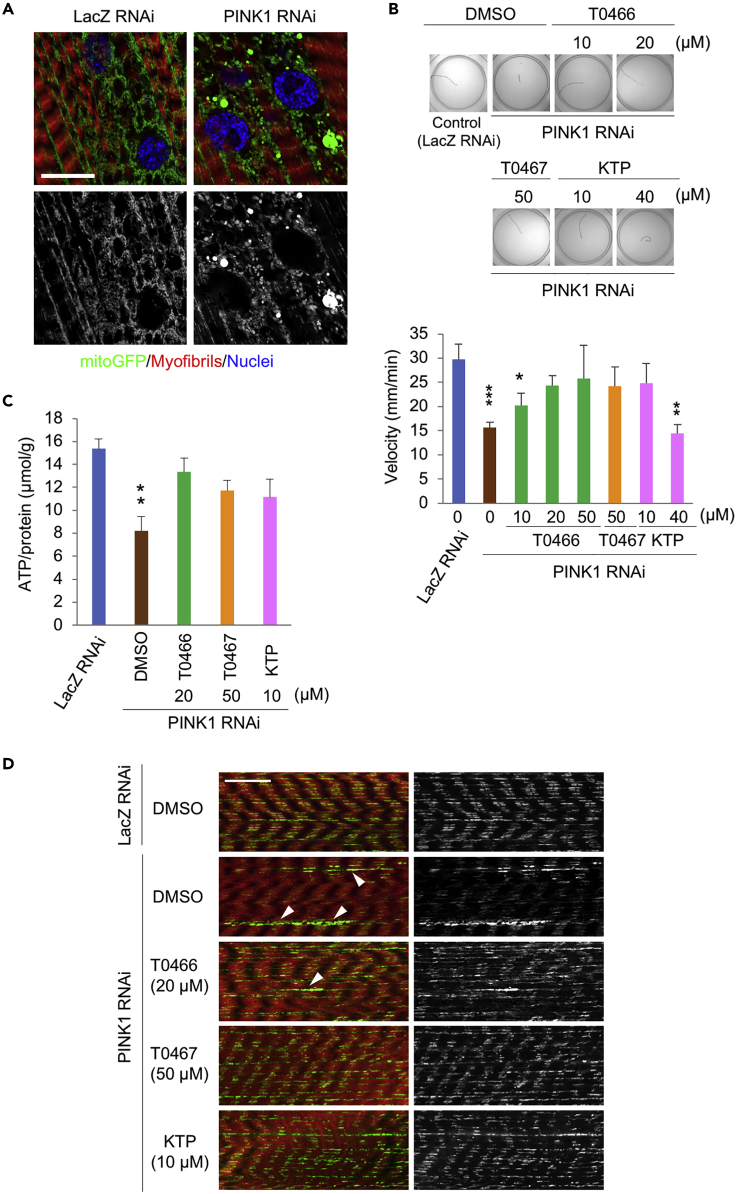
T0466 and T0467 Improve the Locomotion Defects Caused by the Reduced PINK1 Activity in Drosophila(A) Mitochondrial morphological changes caused by PINK1 inactivation in the larval body-wall muscles. Mitochondria were visualized by mitoGFP (green). Myofibrils and nuclei were stained with TRITC-phalloidin (red) and DAPI (blue), respectively. Scale bar, 20 μm.(B) Reduced PINK1 activity-mediated locomotion deficiency is mitigated by T0466 and T0467. Third-instar larvae treated with DMSO or the indicated drugs were placed in the center of 100-mm-diameter dishes and their movement recorded over 2 min using a CCD camera (images). The velocity over the last minute was graphed (mean ± SEM, n = 6–27 flies each). ∗p < 0.05, ∗∗p < 0.01, ∗∗∗p < 0.0001 versus LacZ RNAi by Dunnett's test.(C) ATP production in PINK1 RNAi flies is improved by T0466 and T0467 as well as KTP. ATP concentration was determined in the whole bodies of the third-instar larvae, normalizing with that of tissue soluble proteins. ∗∗p < 0.001 versus LacZ RNAi by Dunnett's test (mean ± SEM, n = 8 flies each).(D) Mitochondrial aggregation in larval body-wall muscles caused by PINK1 inactivation was improved after the administration of T0466, T0467, or KTP. Mitochondria were visualized by mitoGFP (green) and counterstained with TRITC-phalloidin (red). Single channel images of mitoGFP are also shown (grayscale). Typical mitochondrial phenotypes observed in PINK1 RNAi flies are reduced mitoGFP signals and aggregated mitochondria (arrowheads). Scale bar, 20 μm.Genotypes used here are UAS-LacZ RNAi/+; MHC-GAL4/UAS-mitoGFP (LacZ RNAi) and MHC-GAL4, UAS-PINK1 RNAi/UAS-mitoGFP (PINK1 RNAi).See also Figures S5A and S5B.